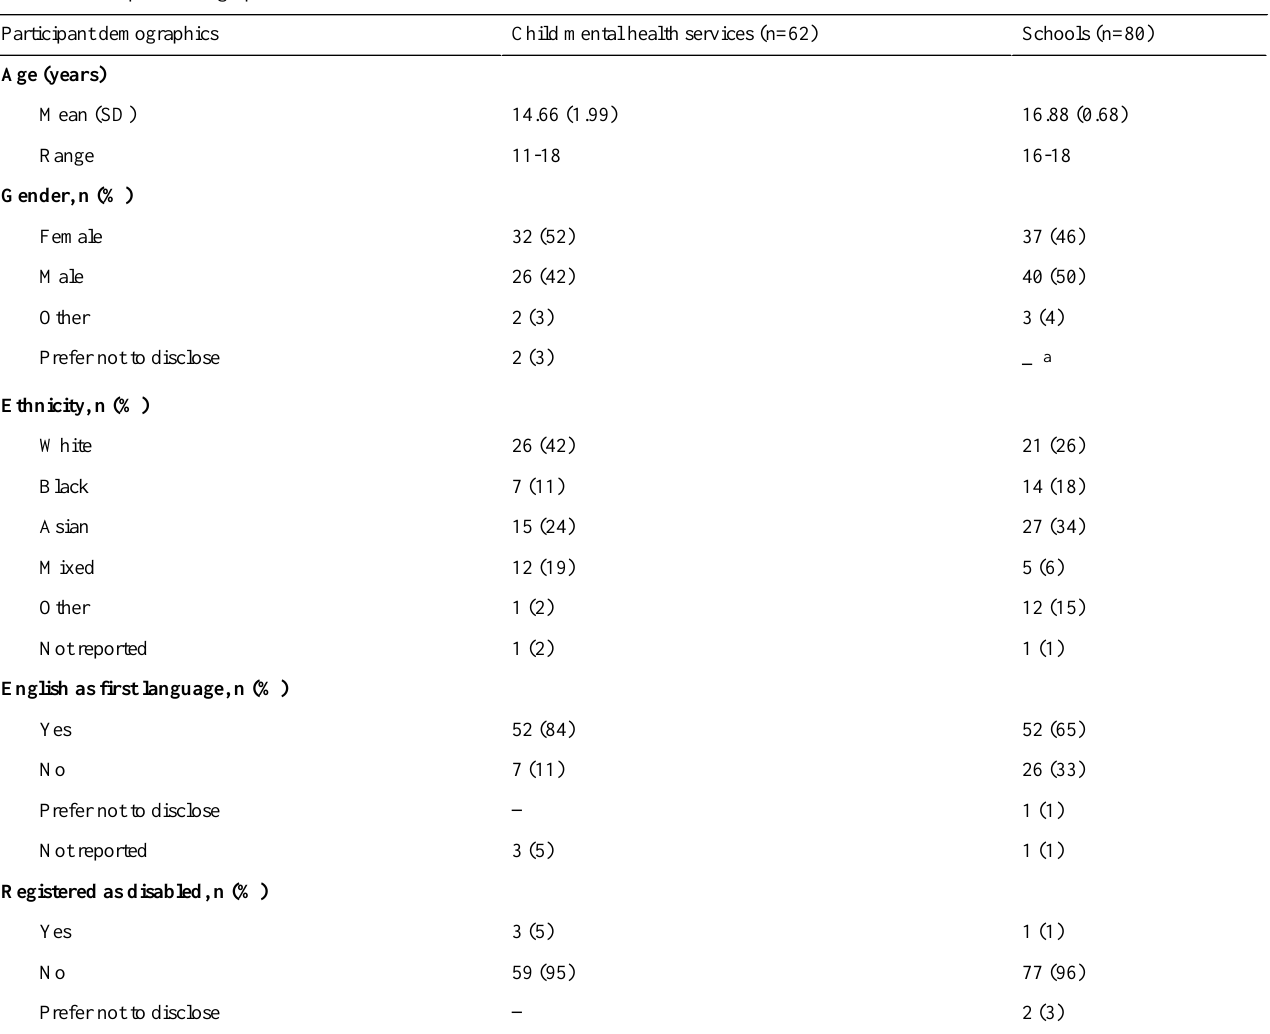
Table 1. Participant